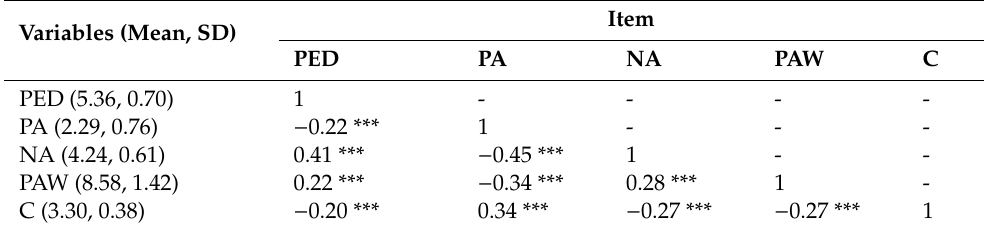
Table 4. Intercorrelations between discrimination (PED), positive a ff ect (PA), negative a ff ect (NA), presenteeism (PAW), and conscientiousness (C).